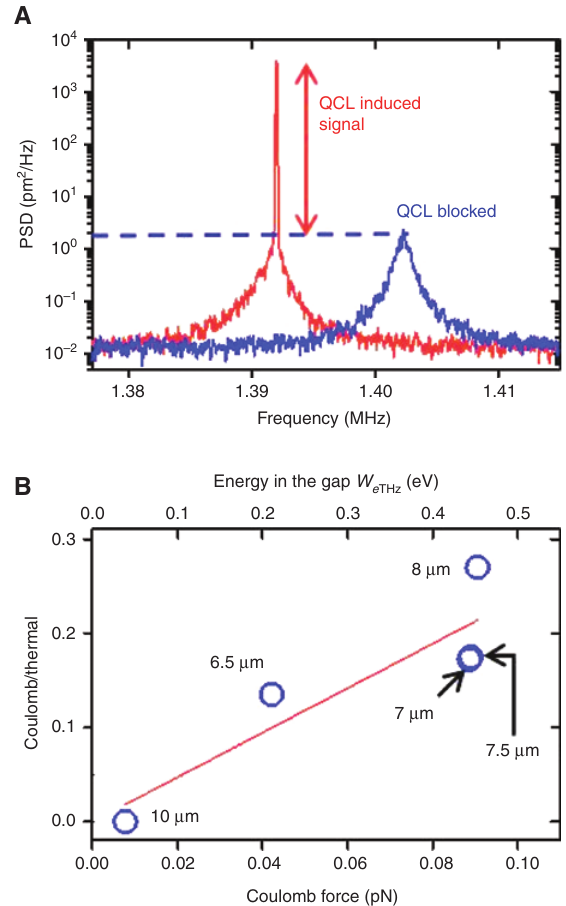
Figure 3: Estimate of the Coulomb force for the first-order mechanical mode. (A) SA spectra recorded with (red curve) and without (blue curve) THz radiation on the sample, with the QCL modulated at the frequency of the mechanical resonance f . The dashed line corresponds to the β peak noise spectral density S ( f ) of the Brownian motion. The 10 kHz β yy